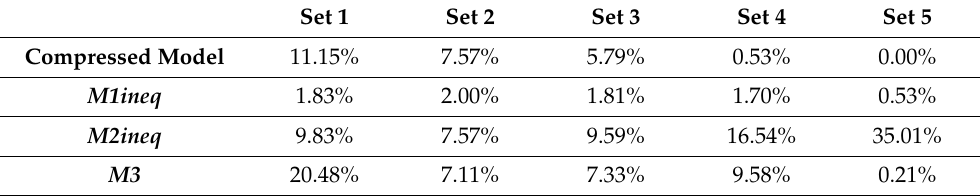
Table 8. Average gap for unsolved